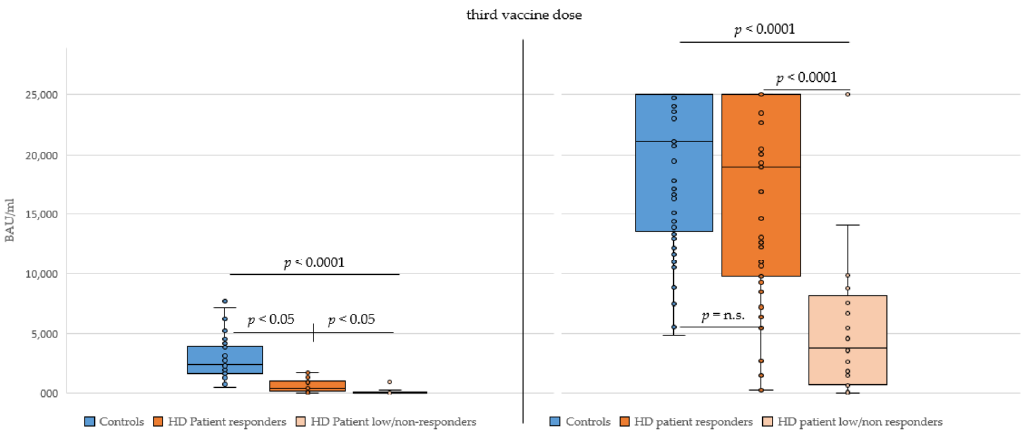
Figure 3. SARS-CoV-2 receptor binding domain-specific antibody titers in Controls and haemodialysis patients (HD patients, split into responder and low/non-responder groups) 6 months after the second vaccine dose ( left ) and 6–8 weeks after the third vaccine dose ( right ). Antibody titers in BAU (binding antibody units) per milliliter. A p value < 0.05 wasconsidered significant; n.s., not significant. The p value in the left figure is for controls vs. all HD patients (responders and low/non- responders